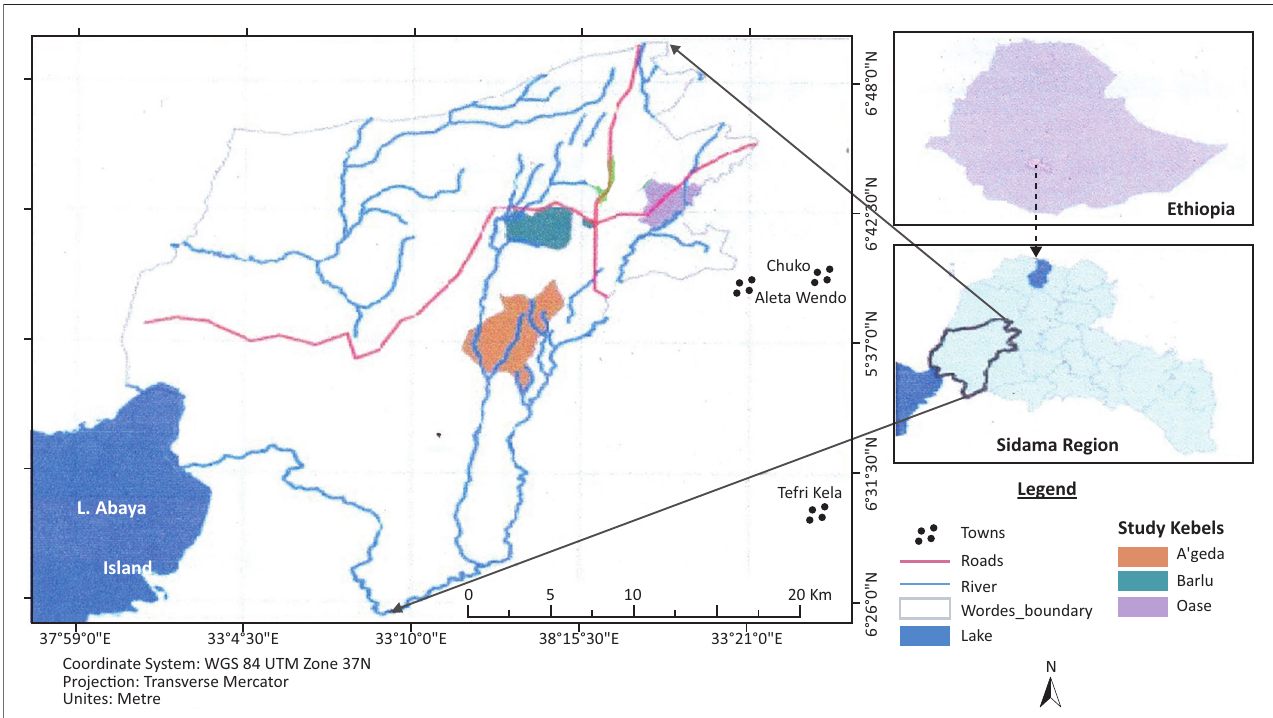
FIGURE 1: Map of the study